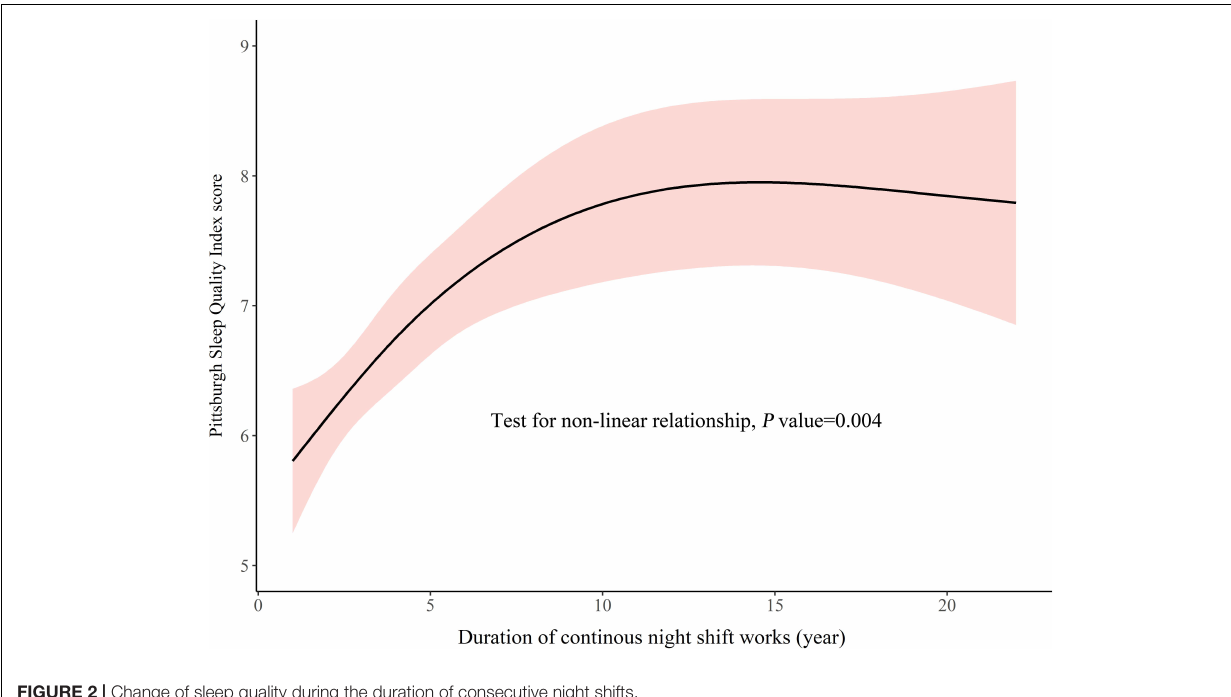
FIGURE 2 | Change of sleep quality during the duration of consecutive night shifts.